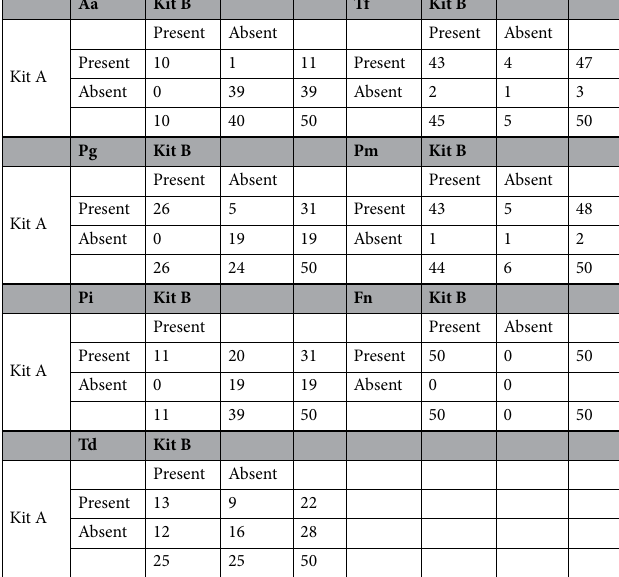
Table 4. Frequency of samples tested positive by two different test kits A and